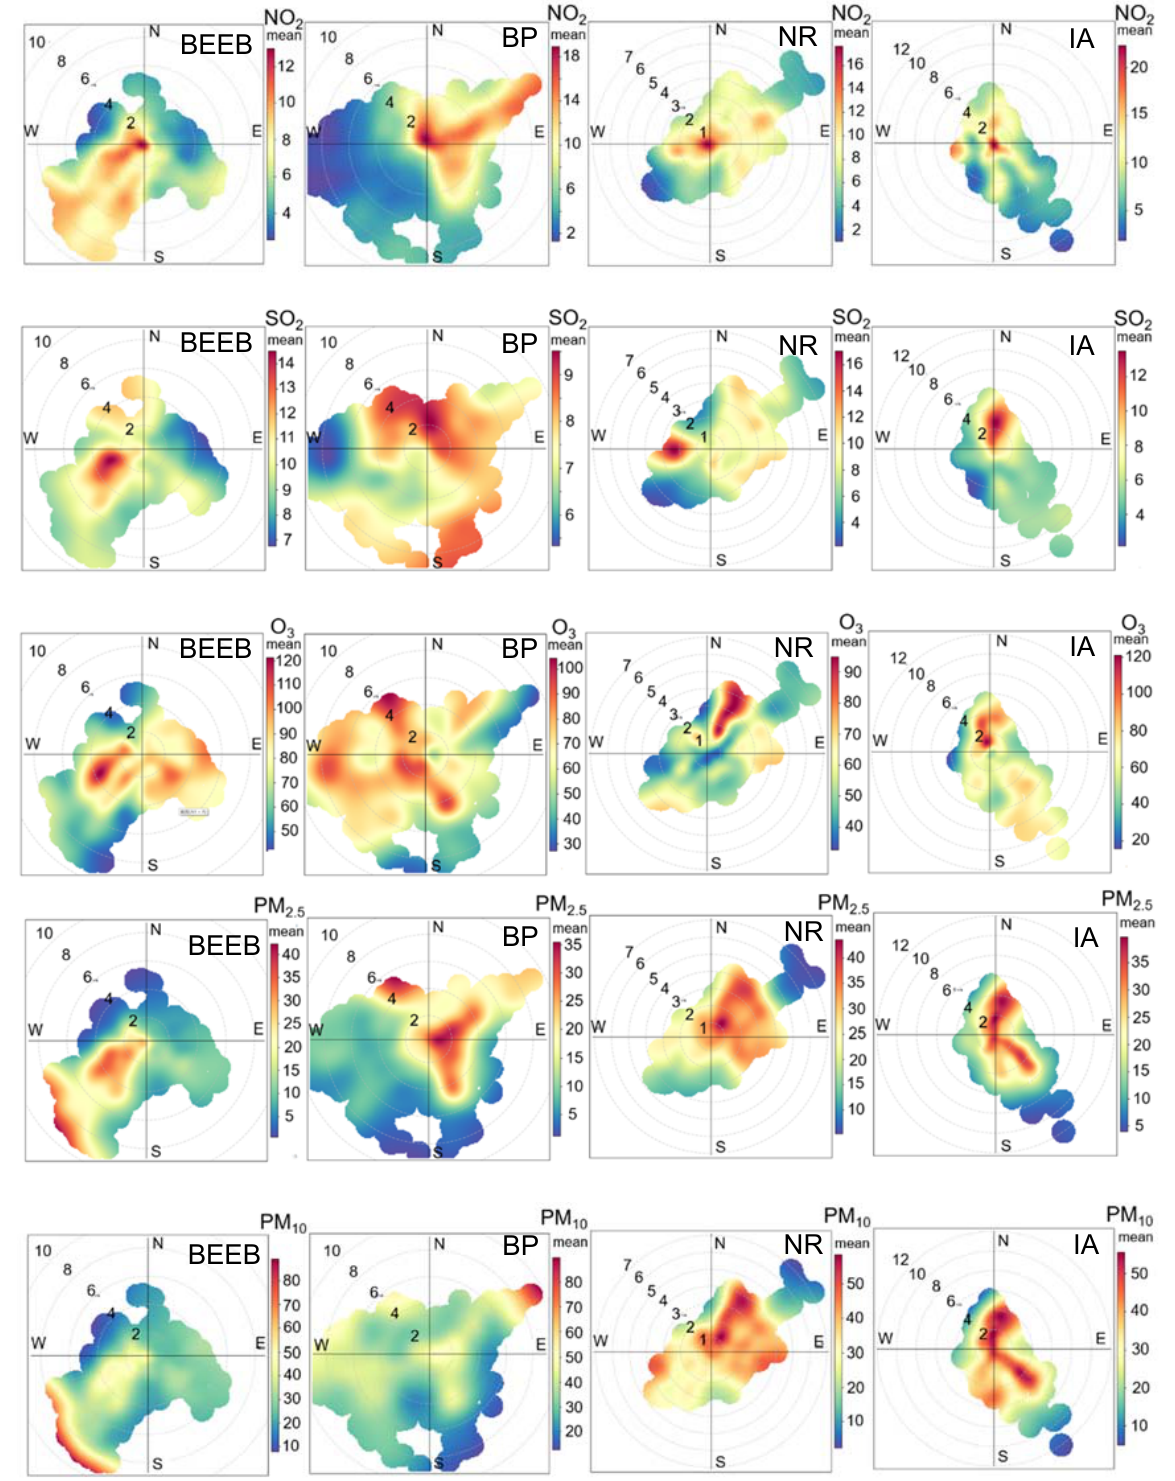
Figure 7. Bivariate polar plots for four national ‐ station ground measurements. BEEB, BP, IA and NR are abbreviations of the names of four national monitoring stations (see Table 1).